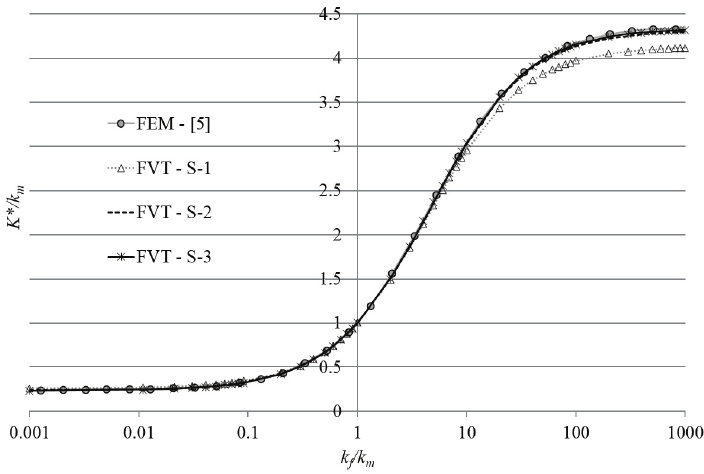
Figure 7. Normalized effective transverse thermal conductivity of the composite with square distribution of